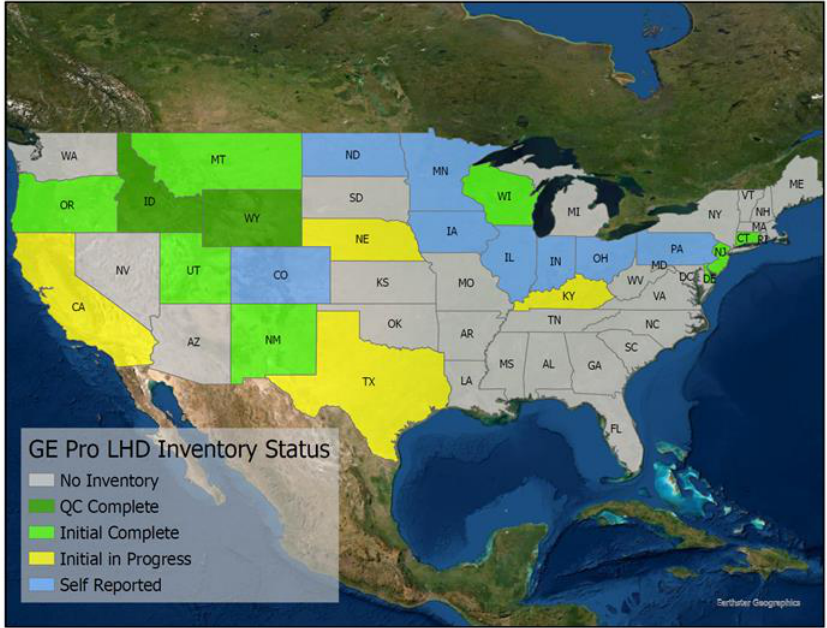
Figure 3. December 2022 status of U.S. National inventory of low-head dams by multi-agency taskforce.